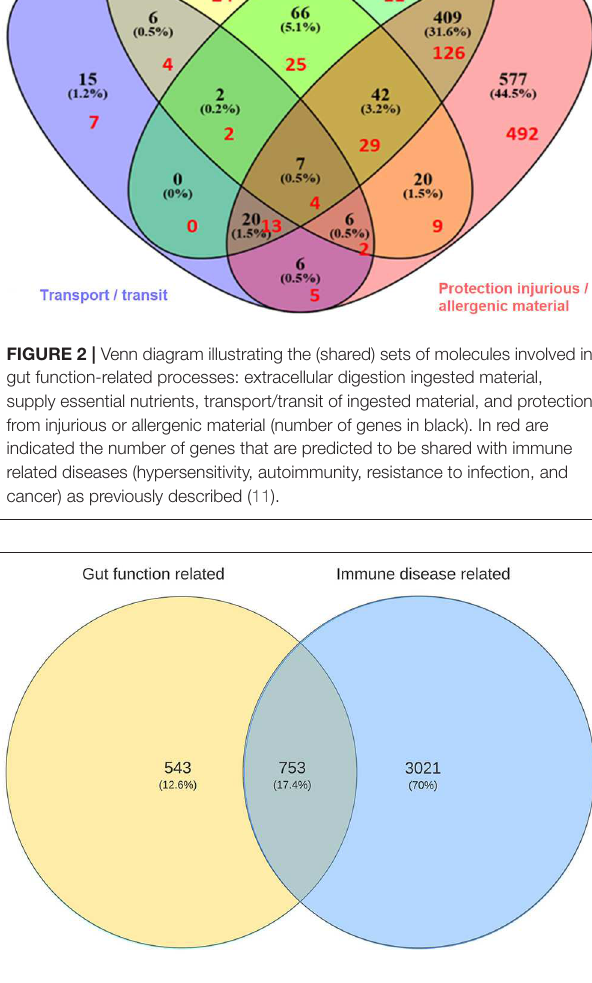
immune system and gut function. These shared genes were evaluated and visualized in Figure 2 (indicated in red). The number of shared genes was as follows: transport/transit ingested material [37 out of 62 transport-related genes shared (60%)], extracellular digestion ingested material [99 out of 246 digestion- related genes shared (40%)], absorption essential nutrients [210 out of 569 absorption-related genes shared (37%)], and protection [680 out of 1100 protection-related genes shared (62%)]. Of the seven genes that were overlapping between all gut functions ( GUCY2C , EPCAM , MYO5B , PYY , SLC10A2 , TNF, and NEUROG3 , as described previously) four genes were also immune disease related genes: GUCY2 , EPCAM , MYO5B , and TNF